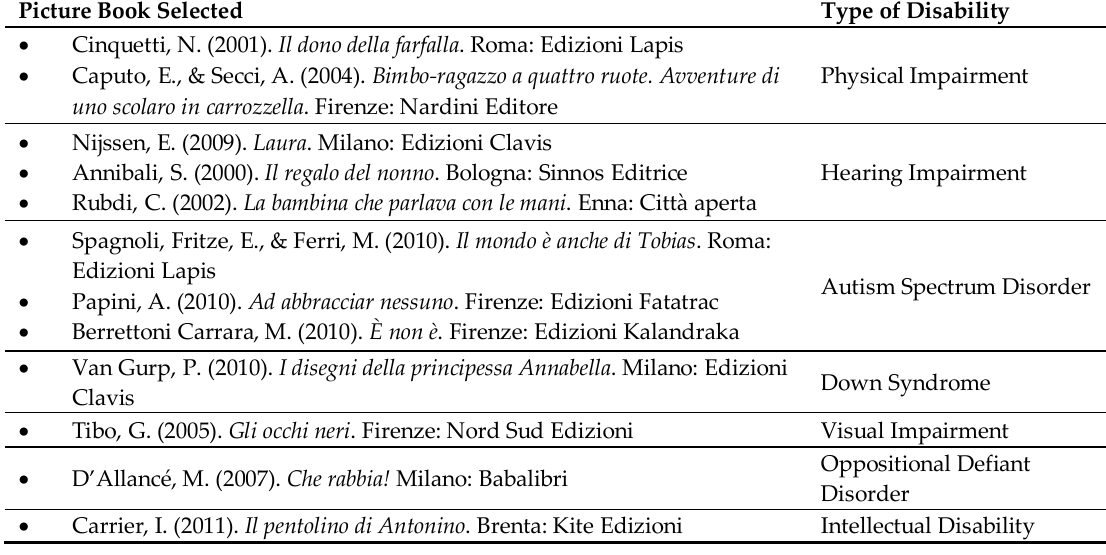
Table 1. Selected picture